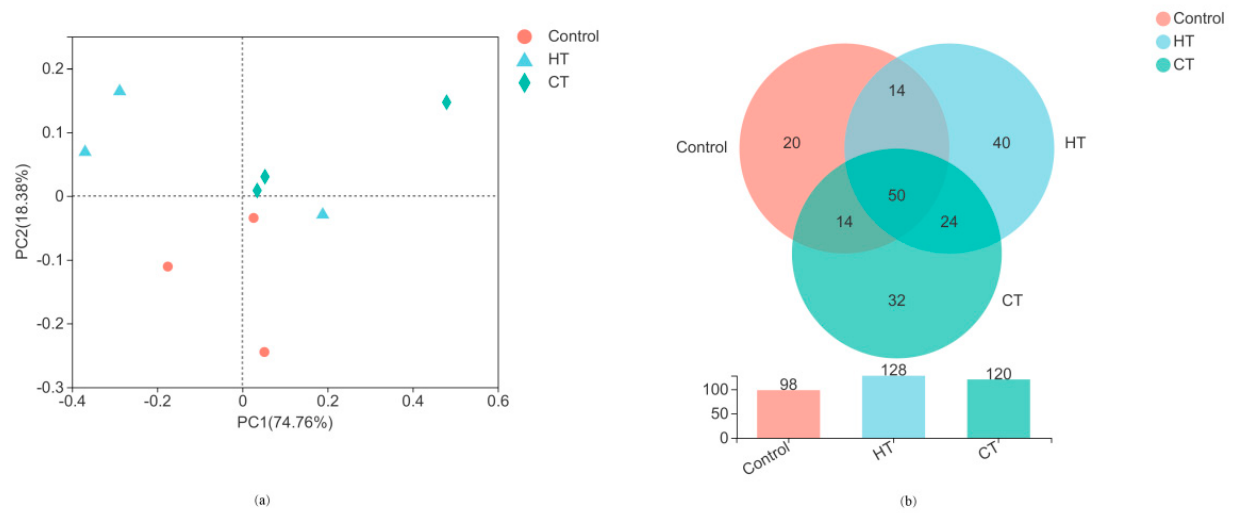
Figure 1. Analysis of the bacterial community of alfalfa silage at the operational taxonomic unit (OTU) level, based on principal coordinate analysis (PCoA, ( a )) and a Venn diagram ( b ). HT = hydrolysable tannin; CT = condensed tannin.